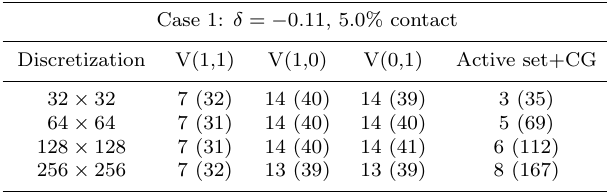
Table 5. Rough contact Case 1: the total number of active set iterations by FMG and the original method, with the numbers of work units in